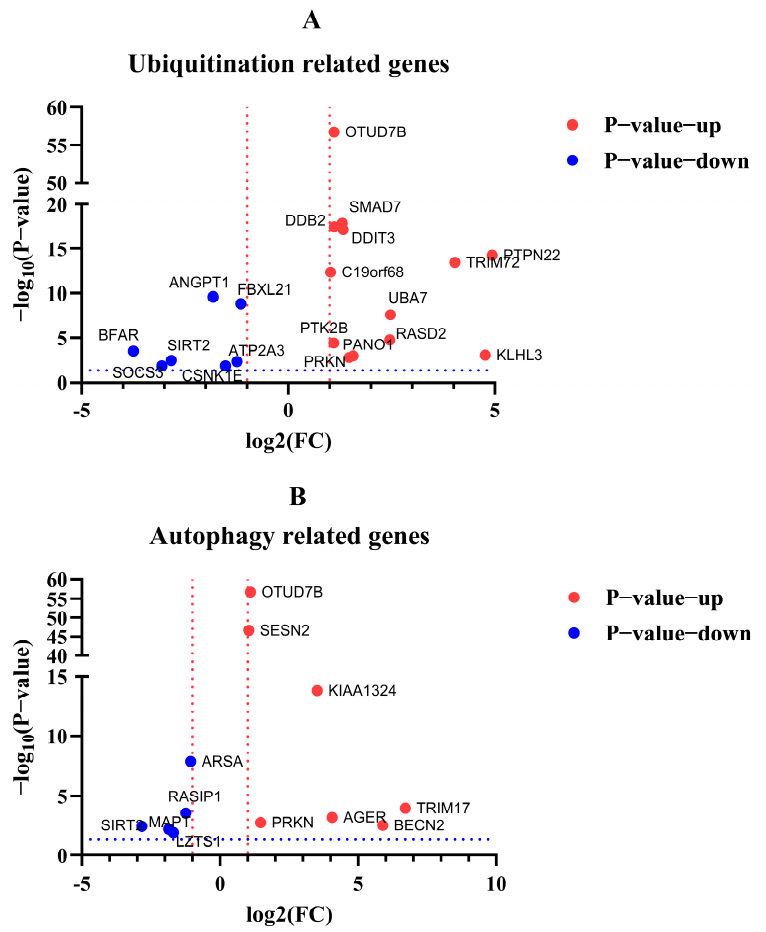
Figure 12. Volcano plot visualization of DEGs related to ubiquitination and autophagy. ( A ) DEGs related to ubiquitination. ( B ) DEGs related to autophagy. Red dotted line indicated the log 2 (FC) > 1 or < − 1. Blue dotted line indicated the − log 2 ( p -value) > − log 10